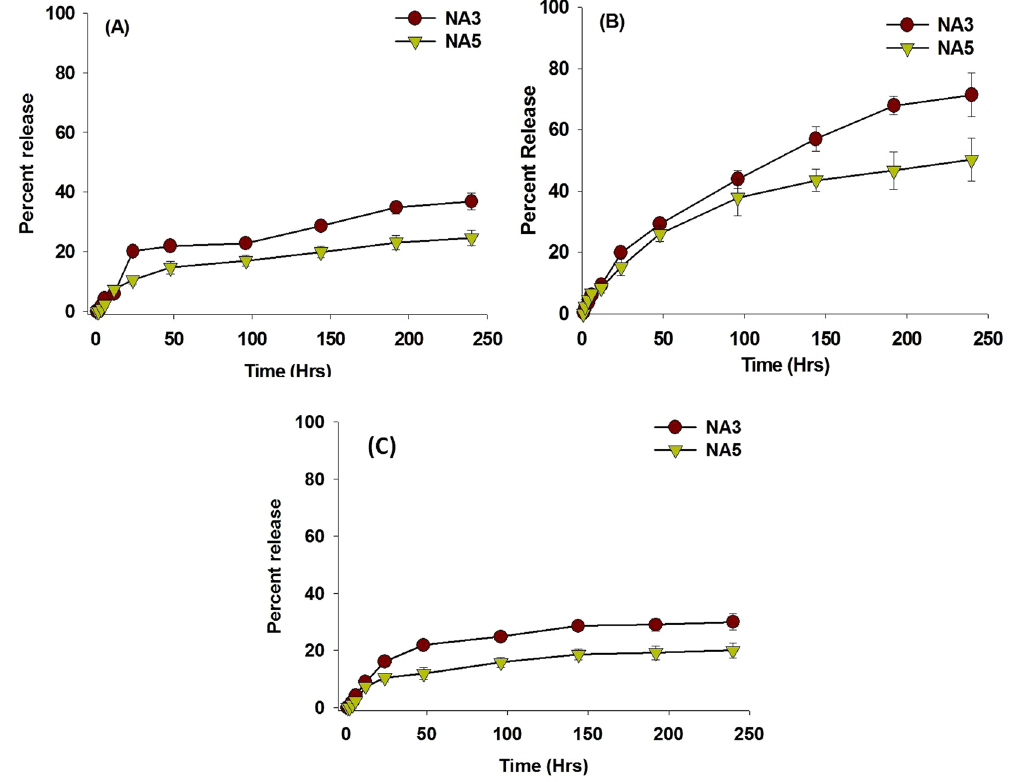
Figure 3. AmB-NA releases monomeric AmB in sustained manner over extended time period: Various AmB-NA formulations were incubated in ( A ) sterile 20 mM phosphate buffer saline (pH 7.4) ( B ) Serum. ( C ) Histidine Buffer. The amount of AmB released at various time points was analysed spectrophotometrically at 405 nm. Each time point represents an average of three runs ±